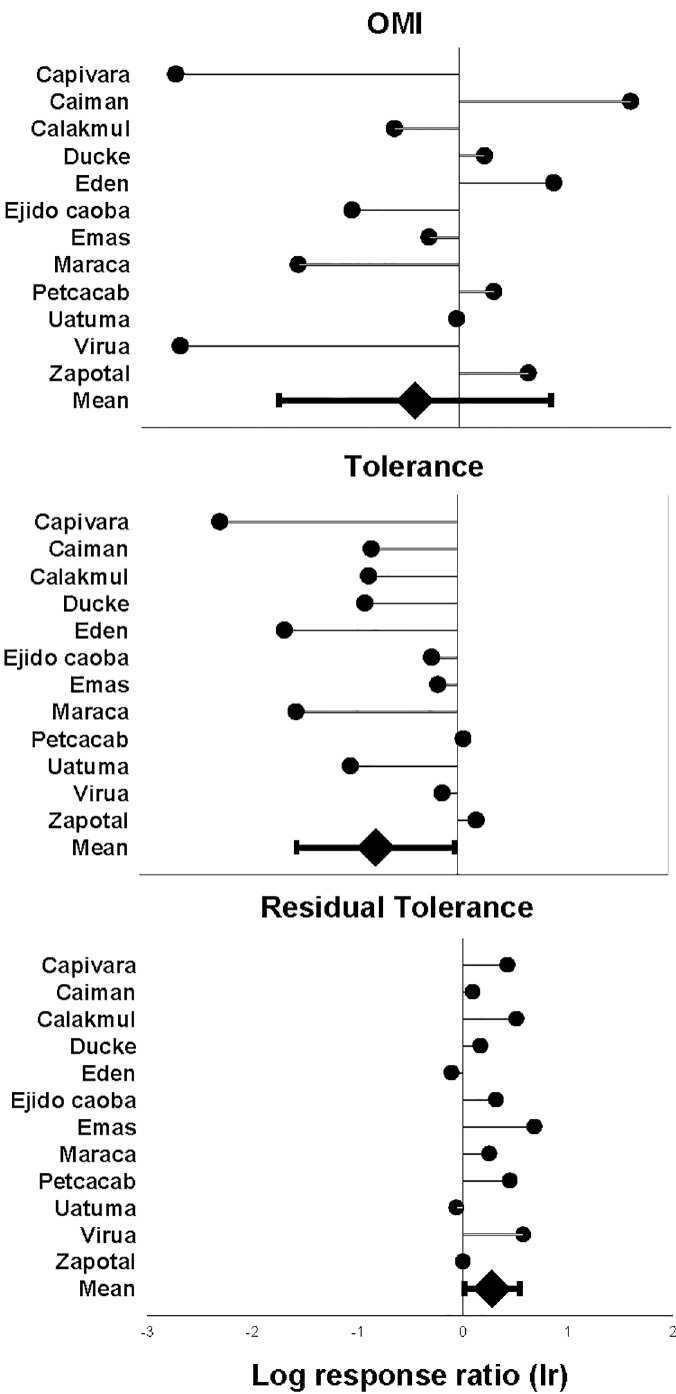
Fig 2. Log response ratio for niche parameters. Log response ratio ( lr ) for OMI (marginality), tolerance and residual tolerance for showing differences in these indices between jaguars and pumas for the 12 study areas. On the graph, zero values of lr means that the two species had identical index values, and a value of 1 (absolute value) means that jaguars (positive values) or pumas (negative values) would have an index value 2.7 times higher than the other species for a given index and study area. Mean lr ( ± SD) is shown at the bottom of each